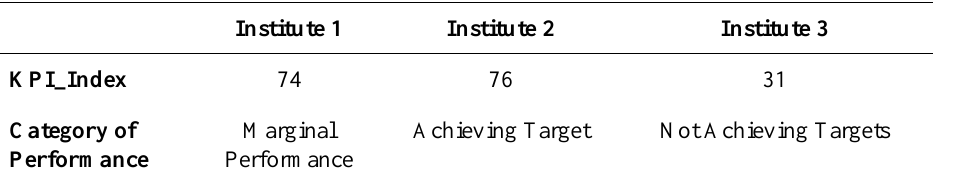
Table 6: Categorisation of Performance According to KPI-Index